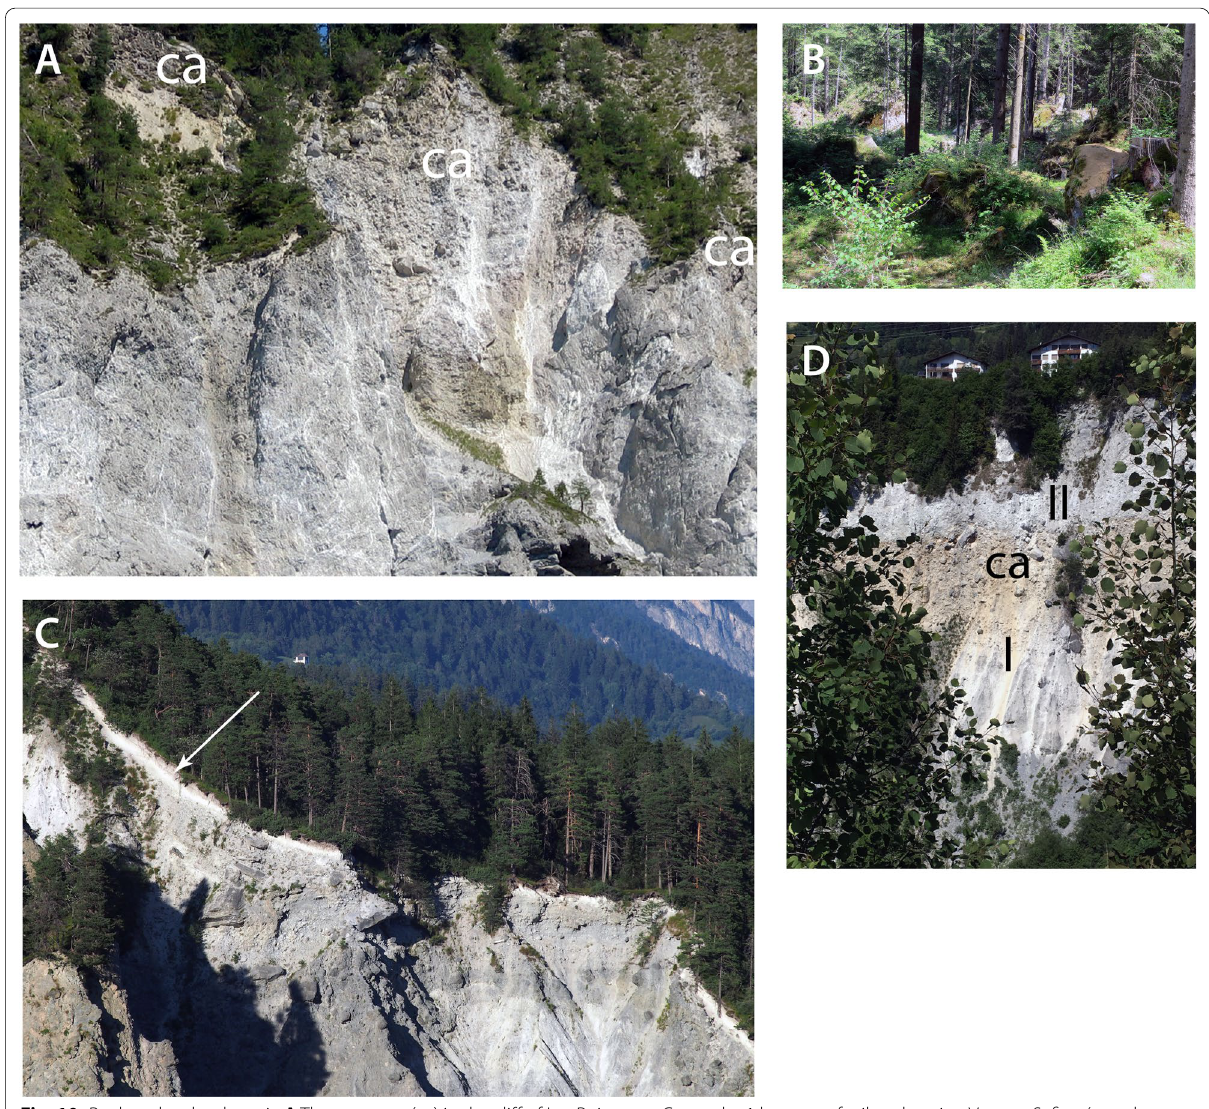
Fig. 10 Rock avalanche deposit. A The carapace (ca) in the cliff of Las Ruinas sut Crestaulta 1 km east of railroad station Versam-Safien (coord. 2744000/1186000). Photo A. Pfiffner. B Carapace blocks in Uaul Zuppau 2 km ESE of Flims Dorf (coord. 2743230/1188000). Photo A. Pfiffner C Dust layer (white arrow) above the carapace photographed 1 km ENE of railroad station Versam-Safien at Las Ruinas sut Crestaulta (coord. 2744000/1186000). Photo courtesy M. Weidmann. D Two rock avalanche deposits (I and II) on top of each other separated by carapace (ca) as seen in the western flank of Val da Mulin (“Laaxertobel”). View is to the west. See text for discussion. Photo A.